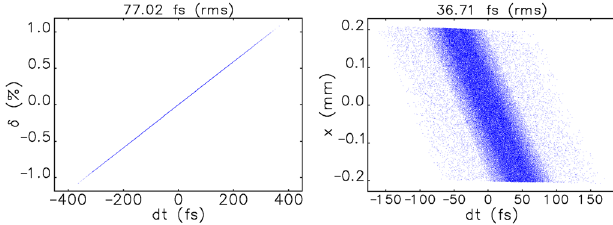
FIG. 13. Final longitudinal phase spaces simulated by IMPACT - T ¼ σ (left) and CSRT rack with σ (right) by tracking only the v; sub v central slice of the bunch. The bunch charge is 2.7